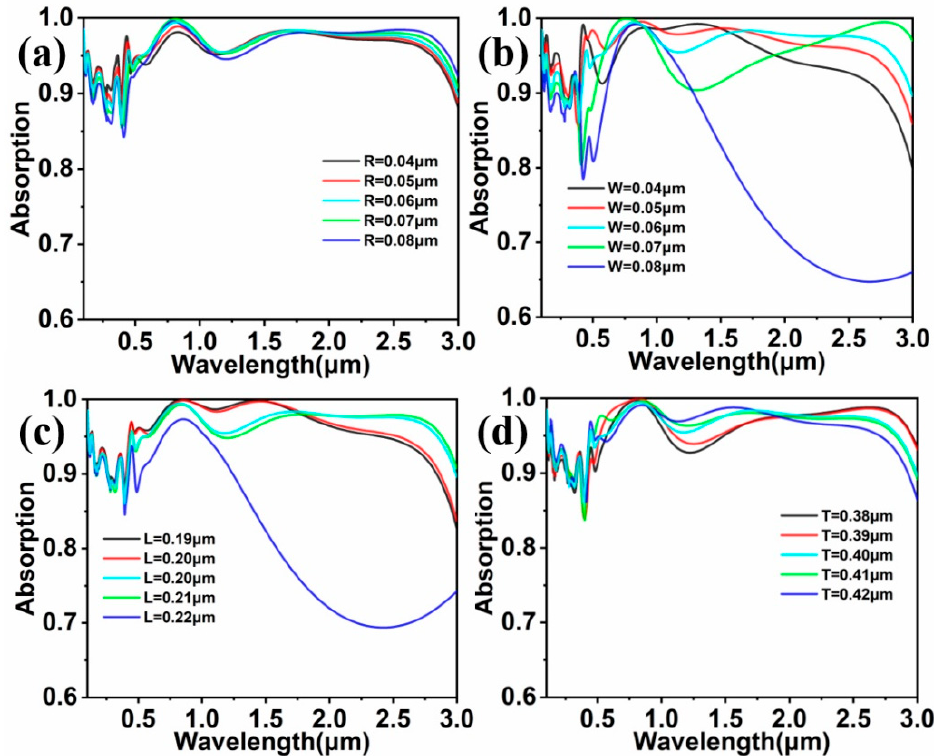
Figure 4. The simulated absorption spectrum of the designed absorber after changing the structural parameters of the surface. ( a ) Absorption spectra at different R; ( b ) Absorption spectra at different W; ( c ) Absorption spectra at different L; ( d ) Absorption spectra at different T